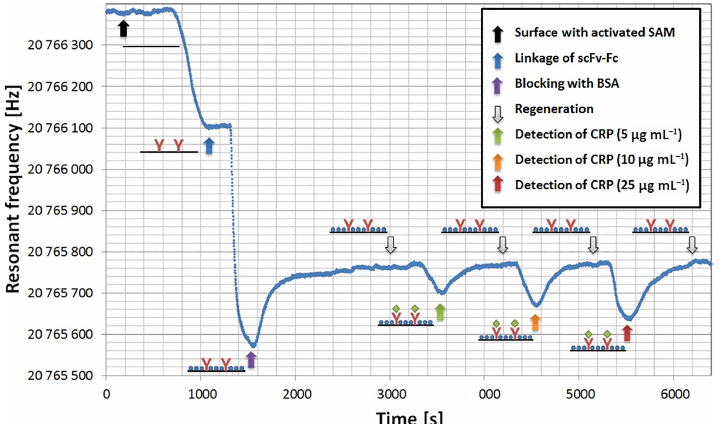
Figure 10. Continuous resonant frequency measurement: after preparation of the chip with antibody and blocking reagent (BSA), different CRP concentrations were